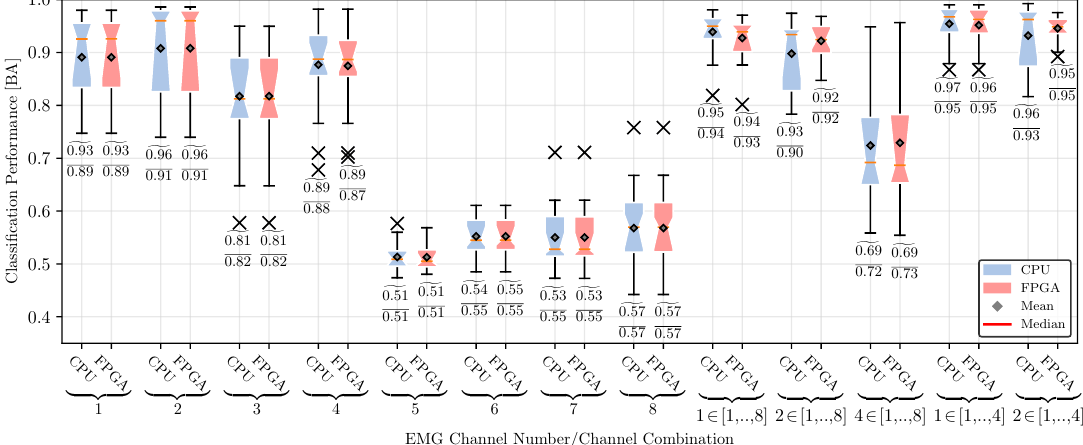
EMG Classification Performance of CPU- and FPGA-based Systems for Different Channel Setups